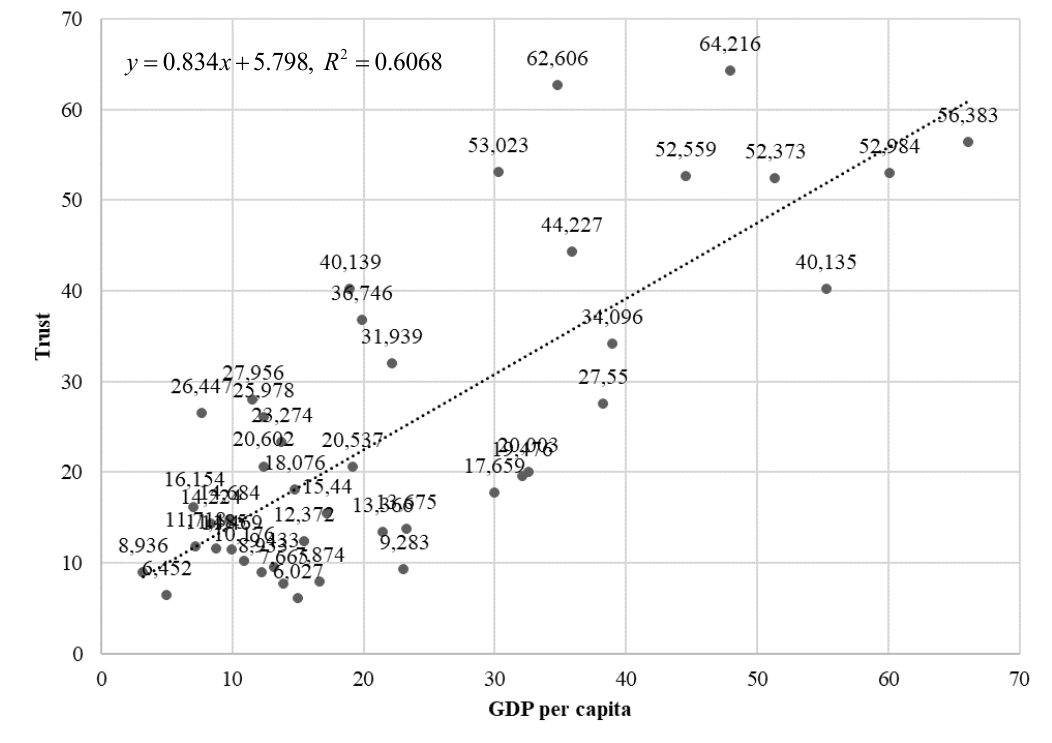
The coefficient of determination indicates that 60.68% of cases of changes in x lead to a change in y . The accuracy of the selection of the regres- sion equation is average. The remaining 39.32% of the change in Y is explained by factors not taken into account in the model (as well as specification errors). The correlation between GDP (in US dollars) per capita and trust of countries, plotted in a chart diagram.